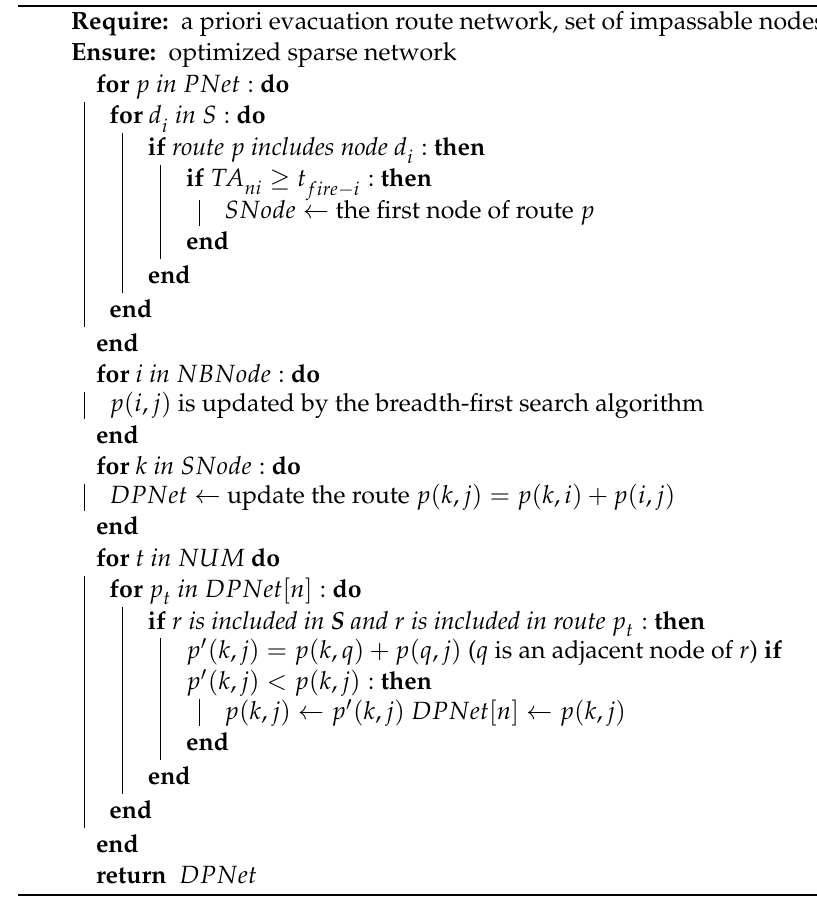
Algorithm 1: Evacuation route dynamic optimization algorithm pseudo